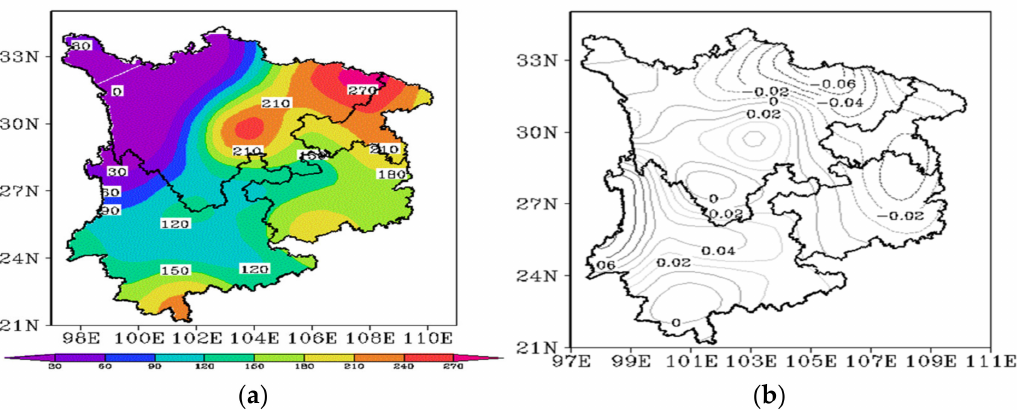
Figure 5. Spatial distribution of rainstorms and floods ( a ) and EOF ( b ) of 90 stations in the summer half year of